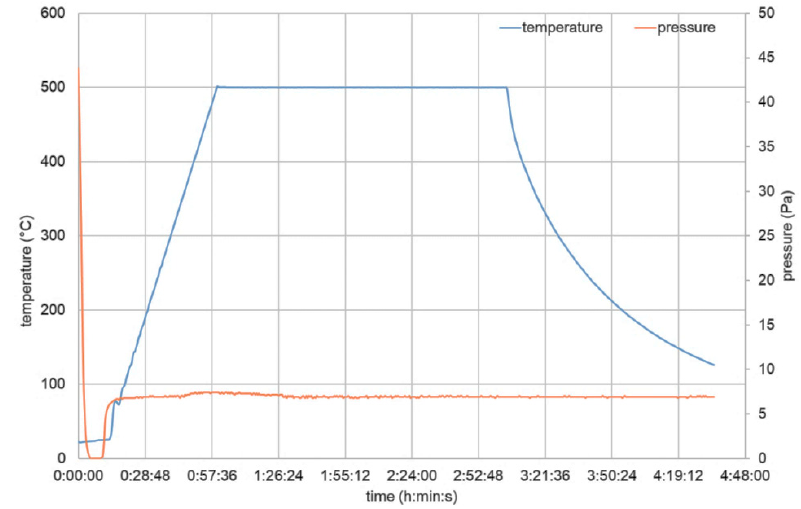
Figure 2. Sintering scheme for Mg-3Sn + 0.2 GNP compacts.